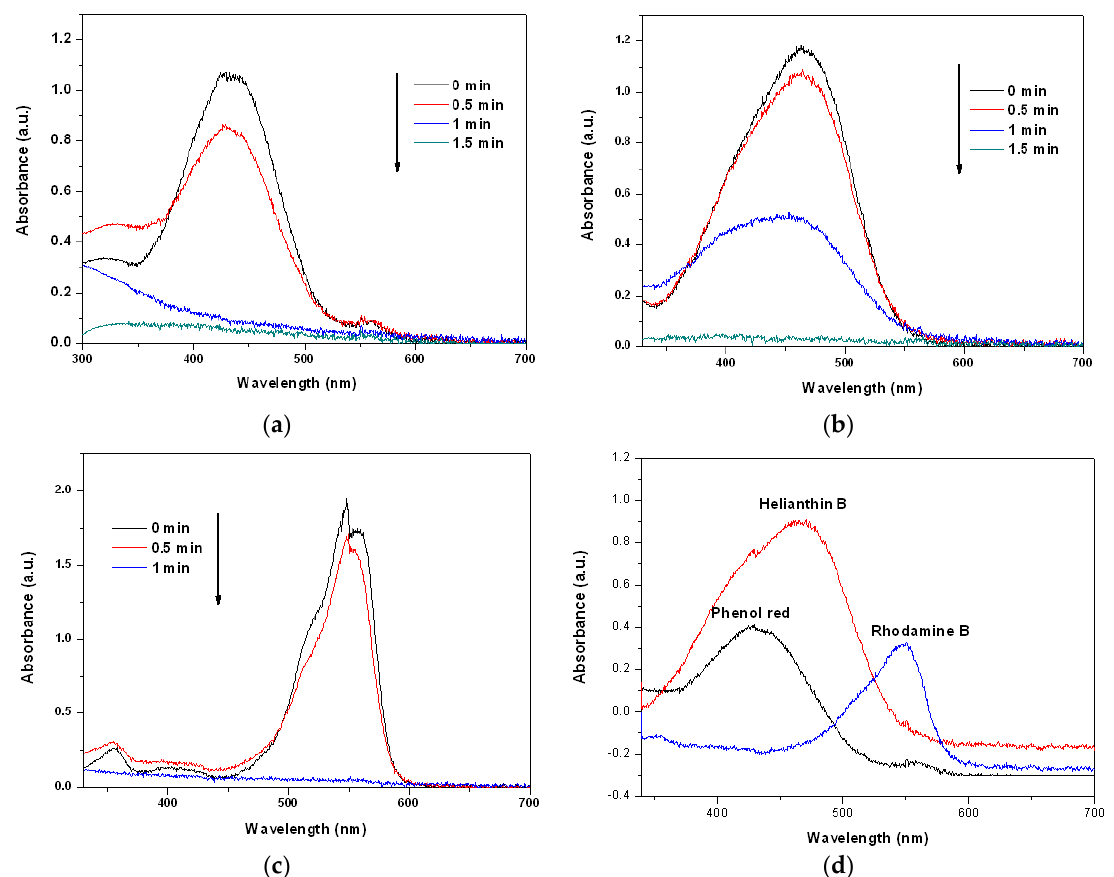
Figure 4. Changes of the UV-Vis spectra of ( a ) phenol red, ( b ) helianthin B, and ( c ) rhodamine B solutions after microwave irradiation in the presence of Cu 2 O solid solution nanoparticles for different periods of time, as well as ( d ) all the phenol red helianthin B and rhodamine B degraded by normal Cu 2 O by microwave irradiation for 5 min.